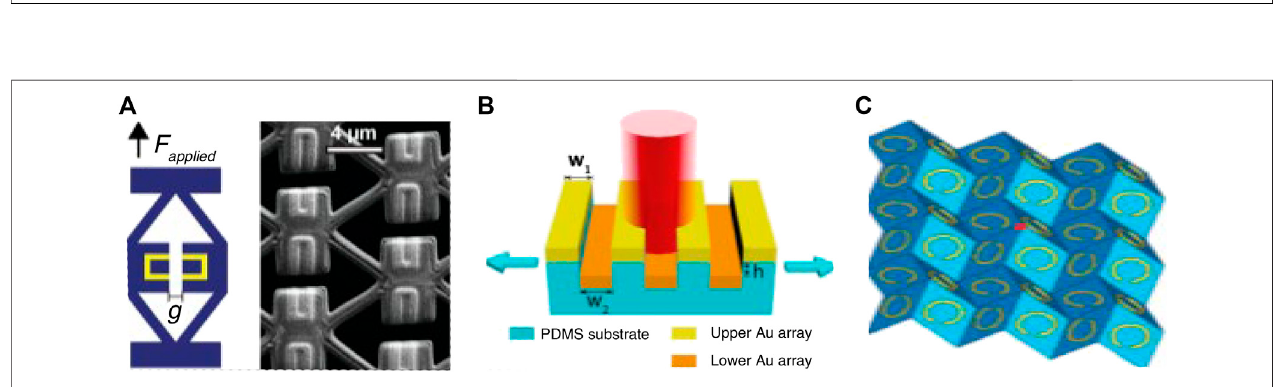
FIGURE 8 | Mechanical reconfigurable metasurface [132 –